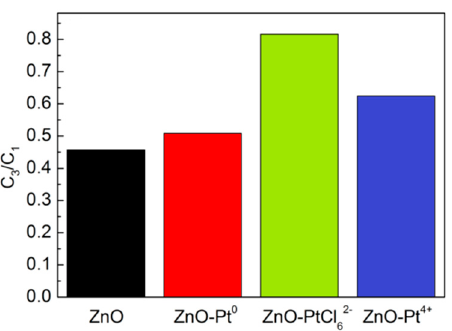
Figure 9. The activity ratio of the third cycle to the first of ZnO, ZnO-Pt 0 , ZnO-PtCl 62 − and ZnO-Pt 4+ .